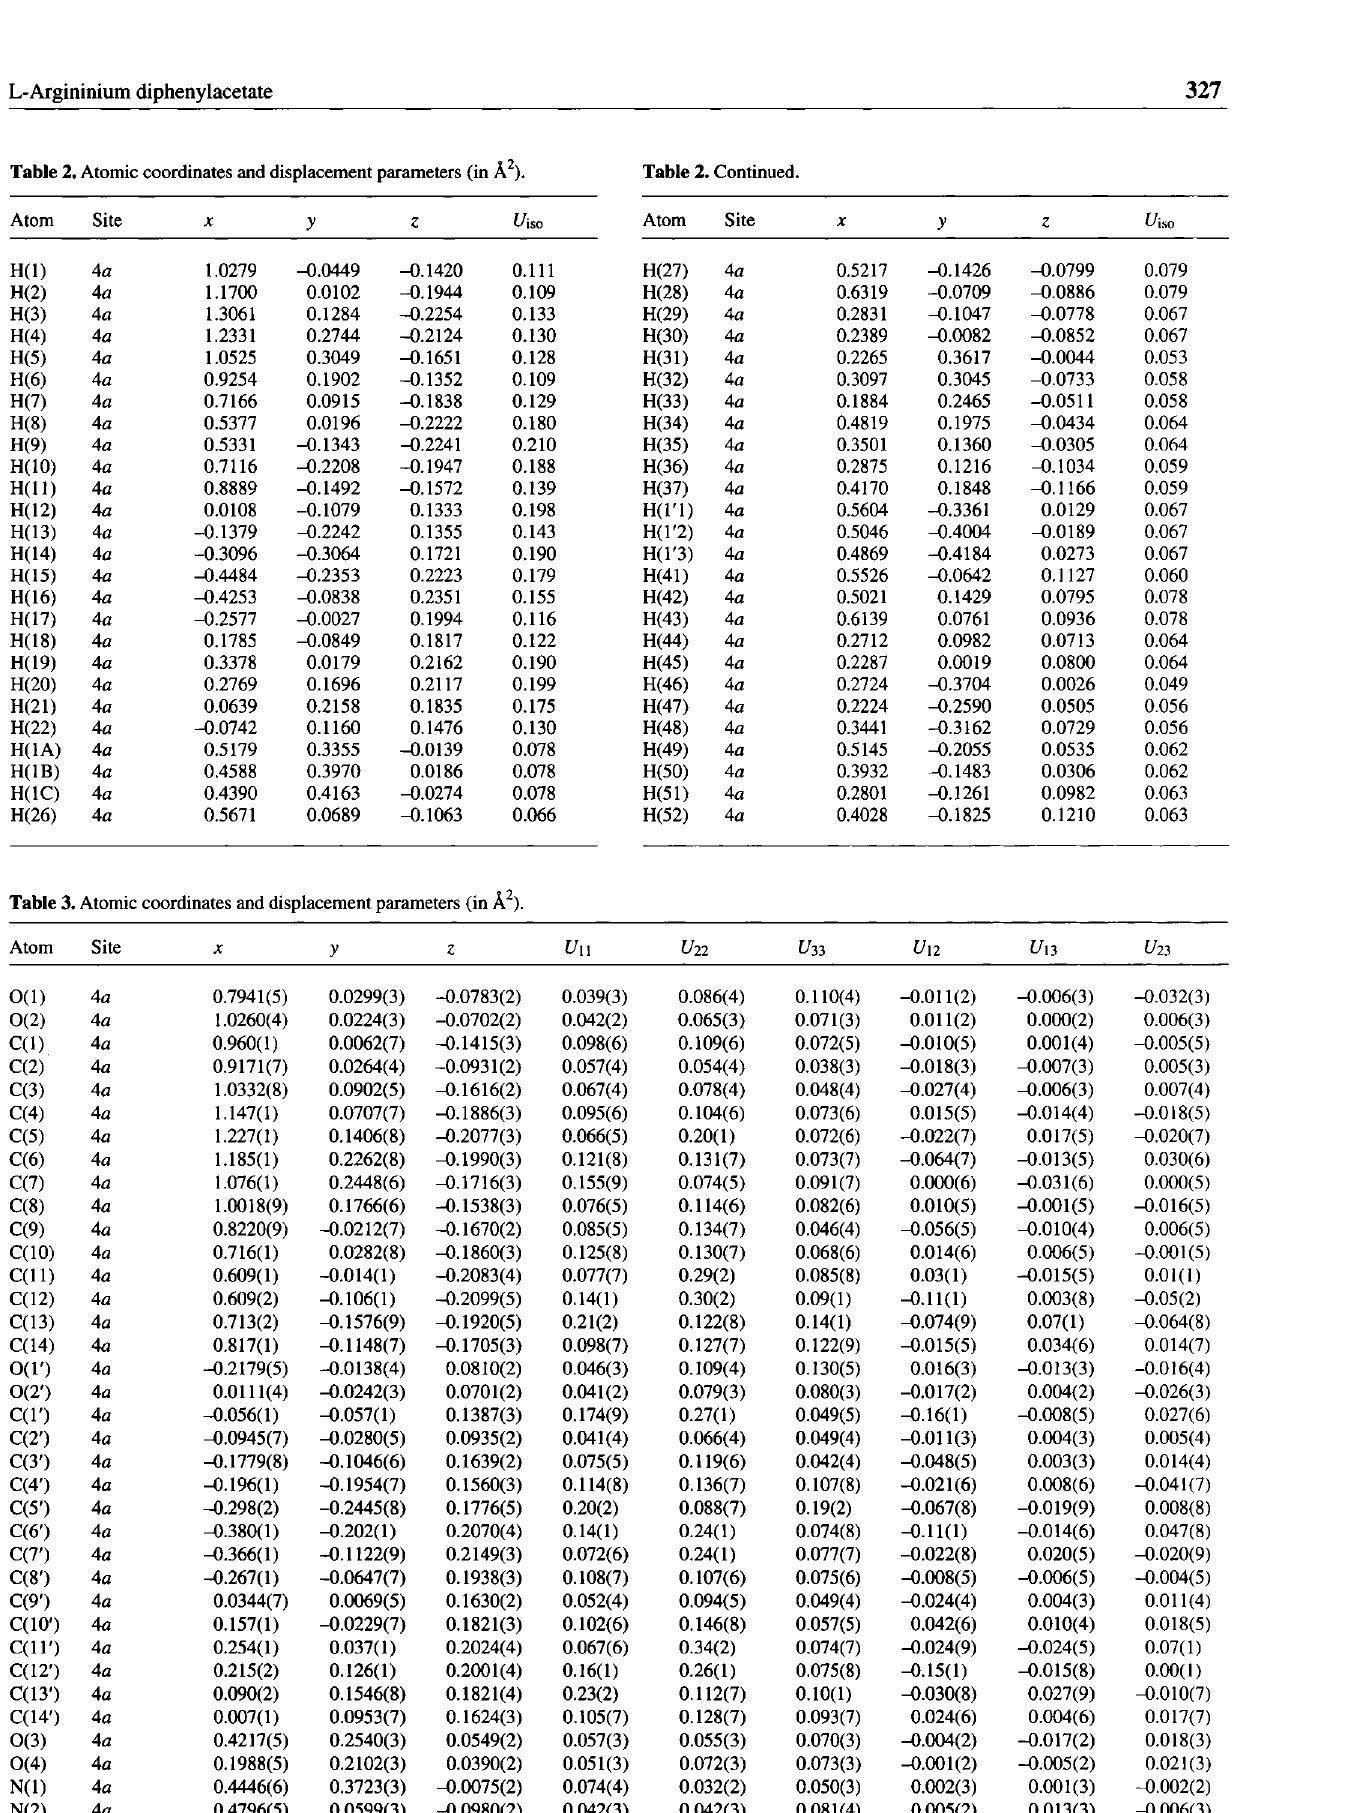
Table 3. Atomic coordinates and displacement parameters (in Â 2